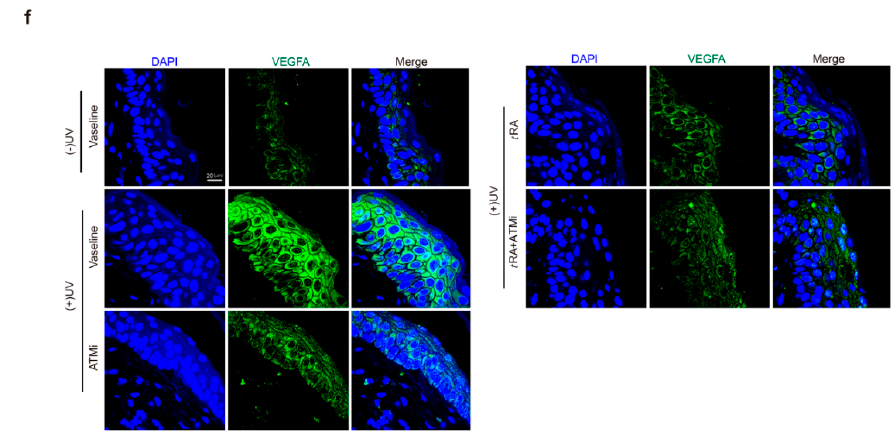
Figure 3. ATM inhibitor enhanced the effect of t RA on the protection of mouse skin from UV-induced VEGFA expression. ( a ) Experimental model. ( b ) mRNA of VEGFA was quantified by RT-PCR. ( c ) Western blot was adopted to analyze VEGFA expression. ( d ) Representative images of VEGFA immunohistochemical staining in cutaneous tissues from C57BL/6 mice with indicated treatments. ( e ) Quantification of VEGFA immunohistochemical staining. ( f ) Immunofluorescence analysis for VEGFA in the skin of mice with indicated treatments. ( g ) Quantification of VEGFA immunofluorescence analysis. Three different fields per section were examined. Data are presented as means ± SEM for three subjects. ( n = 8, * p < 0.05, ** p < 0.01, and *** p < 0.001 versus control group by the Wilcoxon signed-rank test).